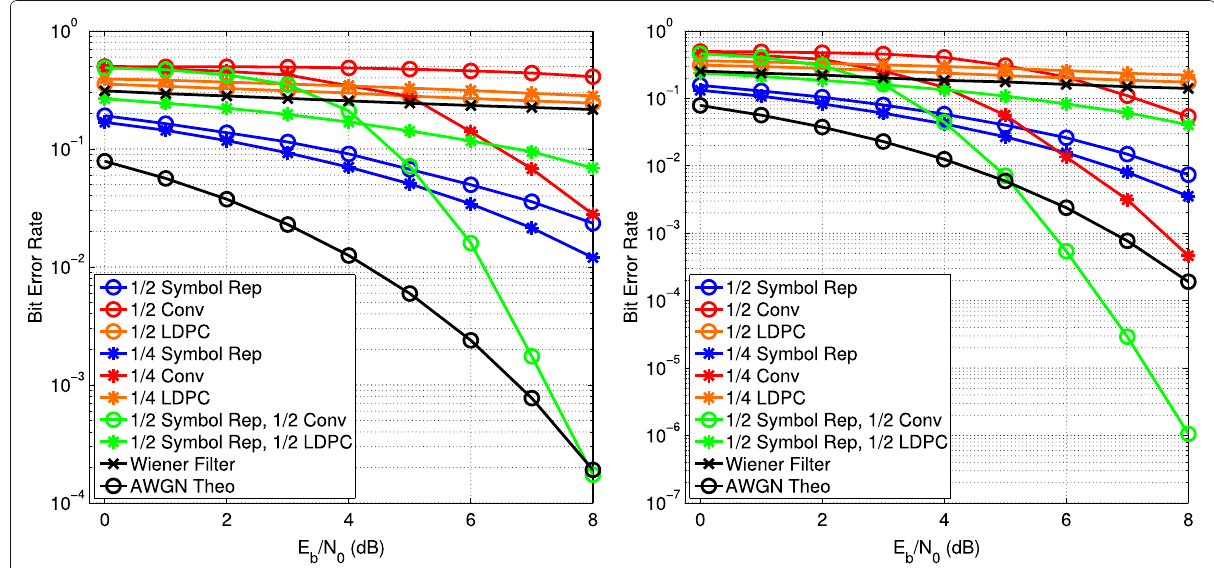
Fig. 9 The BER curves of the filtering methods and error correcting codes while under Rayleigh fading. The BER curves include simulated results for 1/2 Rate Symbol Repetition PFD (blue circle), 1/4 Rate Symbol Repetition PFD (blue star), 1/2 Rate Convolutional Code (red circle), 1/4 Rate Convolutional Code (red star), 1/2 Rate LDPC (orange circle), 1/4 Rate LDPC (orange star), combined 1/2 Rate Symbol Repetition and 1/2 Rate Convolutional Code (green circle), combined 1/2 Rate Symbol Repetition and 1/2 Rate LDPC (green star), Wiener Filter (black x). The AWGN Theoretical is plotted with a black circle. a Bandwidth overlap of 1/2. b Bandwidth overlap of 1/4